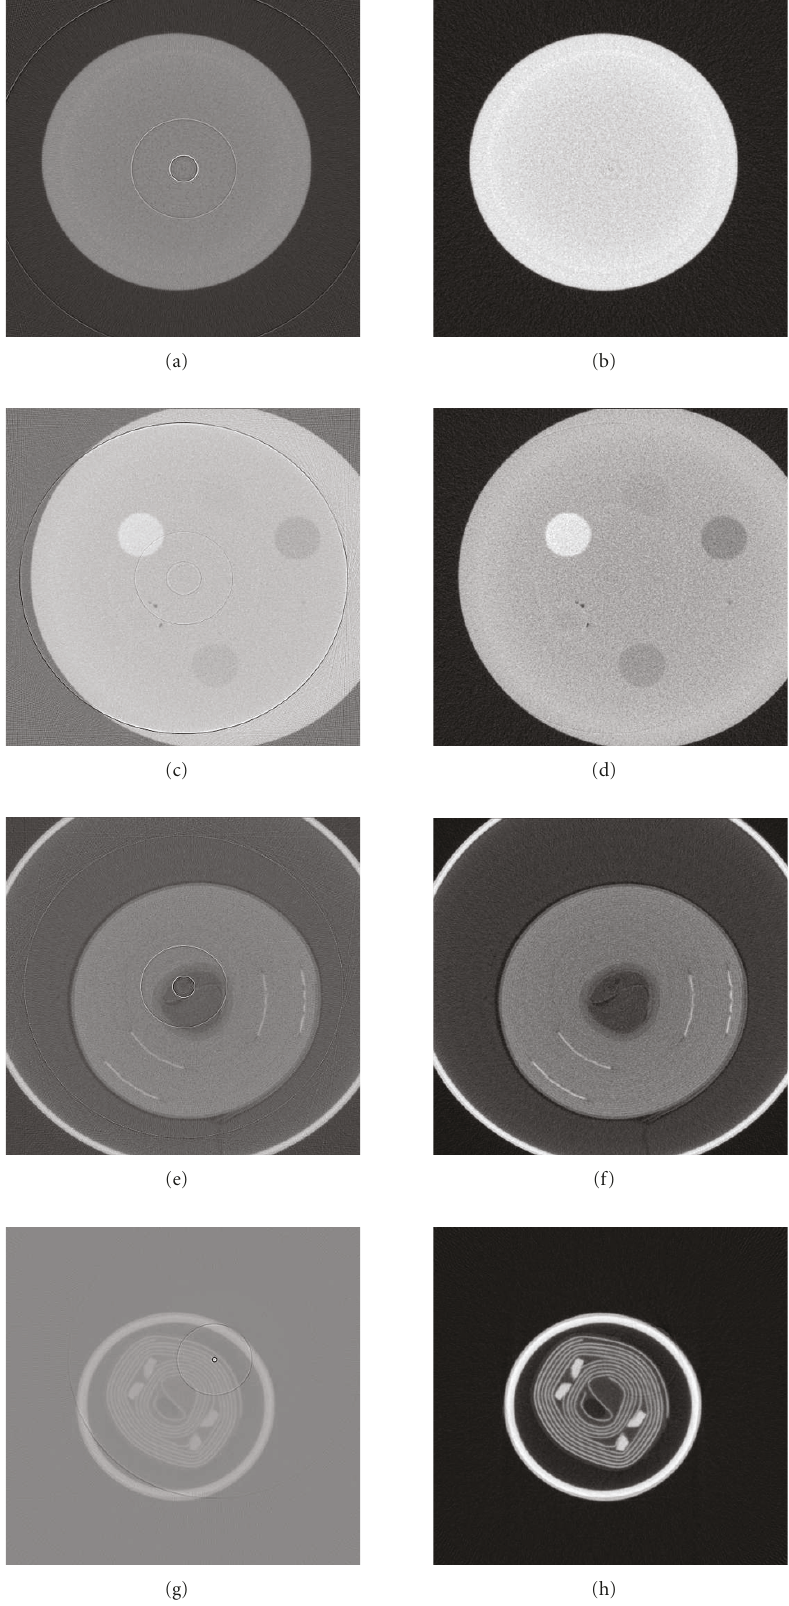
Figure 6: Reconstructed original images corrupted by ring artifact ((a): Water phantom, (c): Contrast phantom, (e): Electrolytic capacitor-1, (g): Electrolyte capacitor-2) and the corresponding ring corrected images using the proposed method ((b), (d), (f), (h),